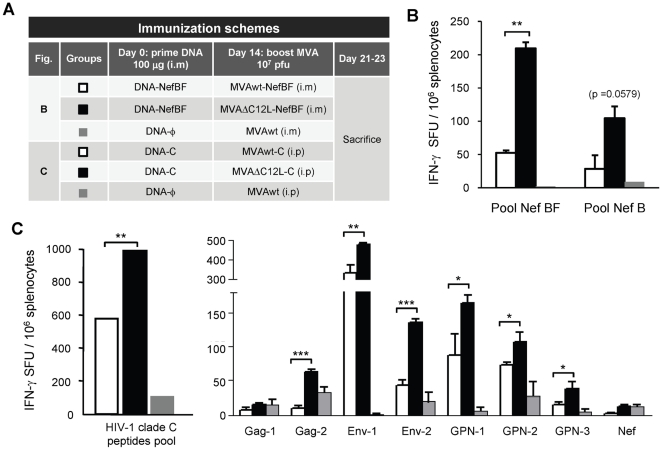
MVAΔC12L induced strengthened cellular responses against recombinant HIV antigens compared to MVA after DNA/MVA immunizations.(A) Description of the different vectors employed in the DNA/MVA immunization schemes applied, each group consisted of three to four BALB/c mice. (B) Seven days after the boost, specific-CD8+ T-cell responses against NefBF (homologous) or NefB (heterologous) peptides were evaluated in the spleen. (C) Ten days after the boost specific responses against HIV-1 subtype C antigens were evaluated in the spleen. To the left it is depicted the responses found against the total pool of peptides analyzed, in the right panel it can be seen the detailed analysis showing the pool of peptides targeted comprising the different HIV antigens that are expressed from the vectors. The magnitude of the response was measured by IFN-γ Elispot assay after 24 hr stimulation. Background (RPMI control) subtracted results are depicted as mean IFN-γ spot forming units (SFU) per 106 splenocytes ± SD. Statistically significant differences: *p<0.05, **p<0.01, ***p<0.001.